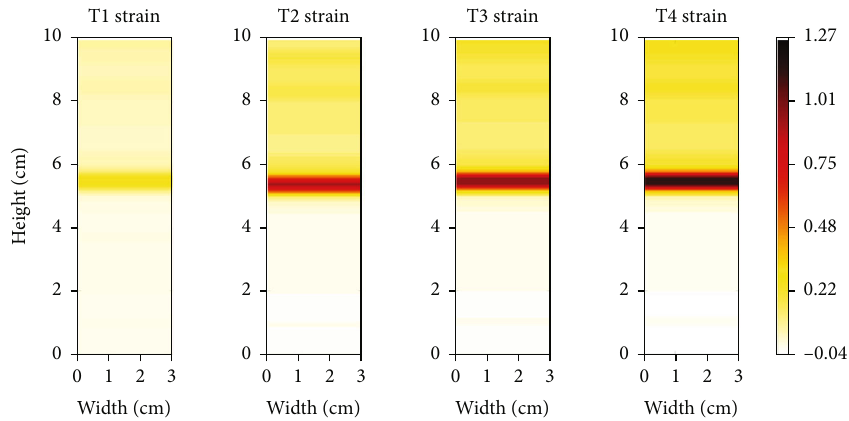
Figure 13: The vertical strain fi eld distributions of the soil columns after freezing 144 h.